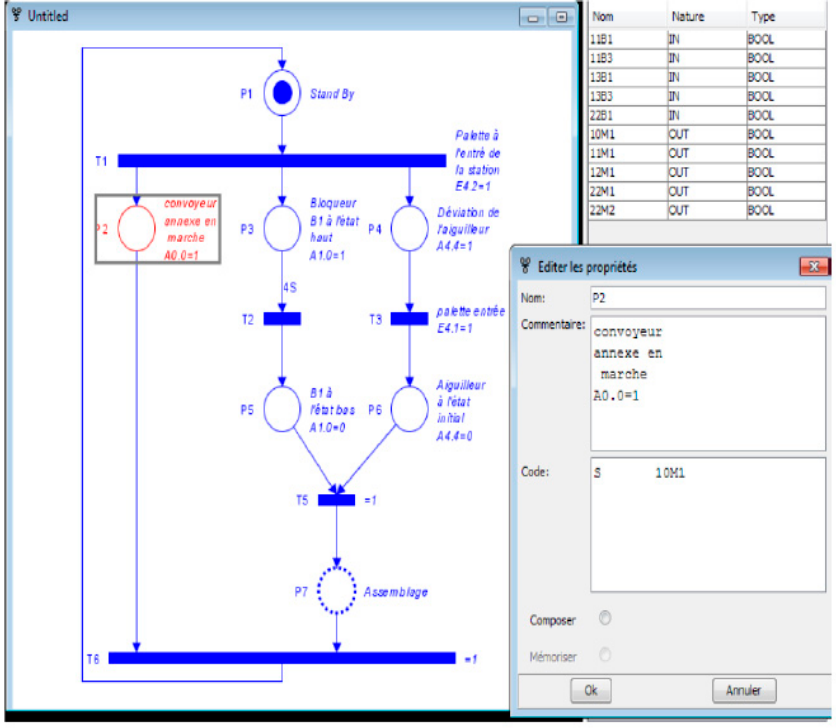
Figure 6. A screenshot of the application interface.